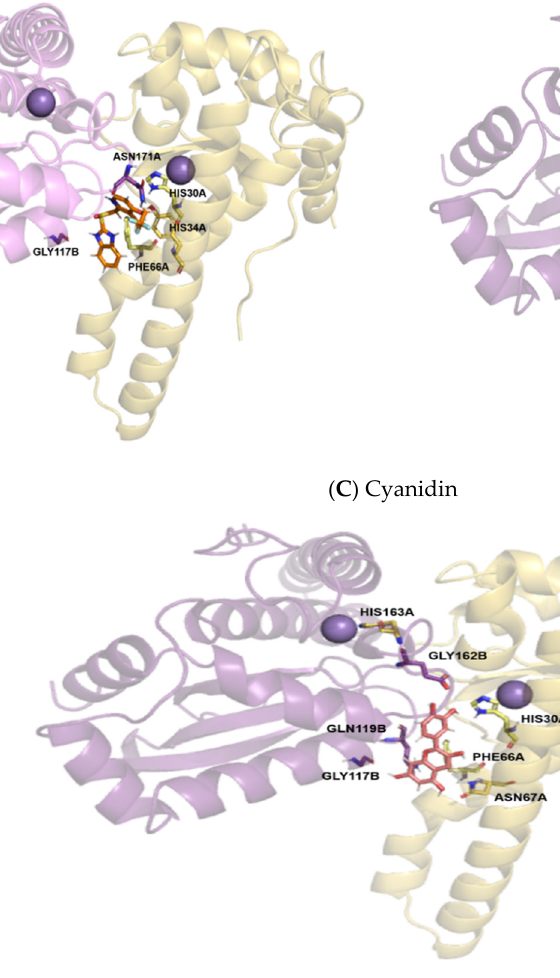
Figure 11. Molecular coupling of the lansoprazole ( A ), malvidin ( B ) and cyanidin ( C ) molecule in the Superoxide dismutase (SOD) protein structure–PDB 1N0J, between the A and B chains. ( A ) Lan ‐ soprazole molecule colored in orange, best pose with − 7.2 kcal/mol (affinity energy), Mn 2+ ion shown colored in purple ball . ( B ) Malvidin: Best pose with − 7.5 kcal/mol (affinity energy), Mn 2+ ion shown colored in purple ball, malvidin molecule colored in bluish ‐ green. ( C ) Cyanidin: Best pose with − 8.6 kcal/mol (affinity energy), Mn 2+ ion shown colored in purple ball, cyanidin molecule colored in pink.